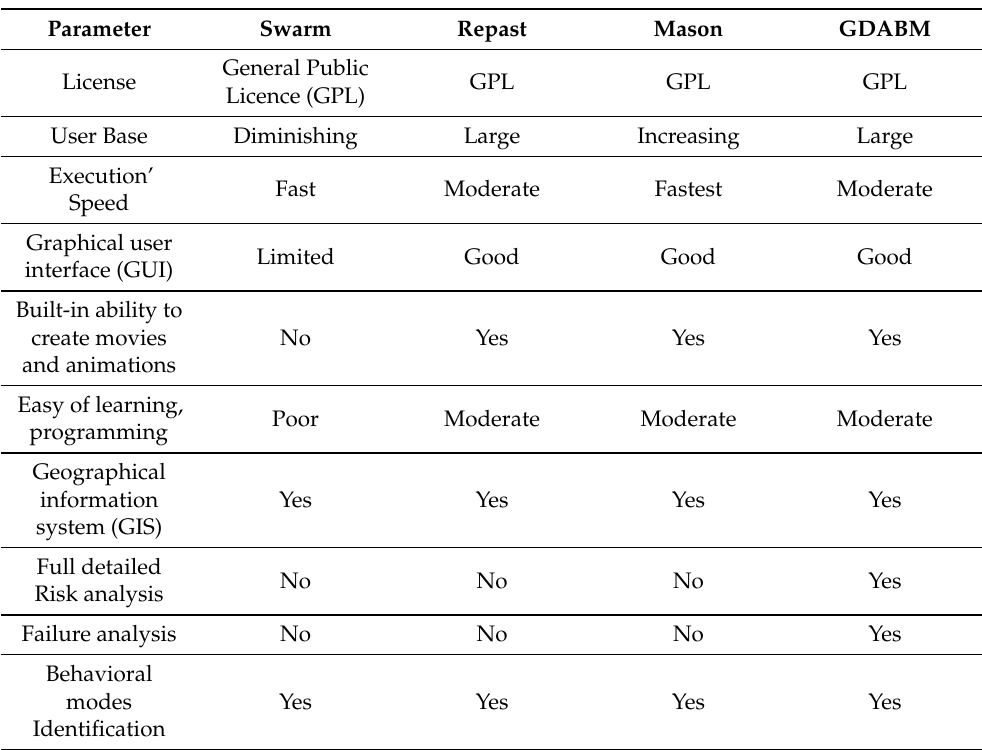
Table 6. Comparison between GDABM and reference